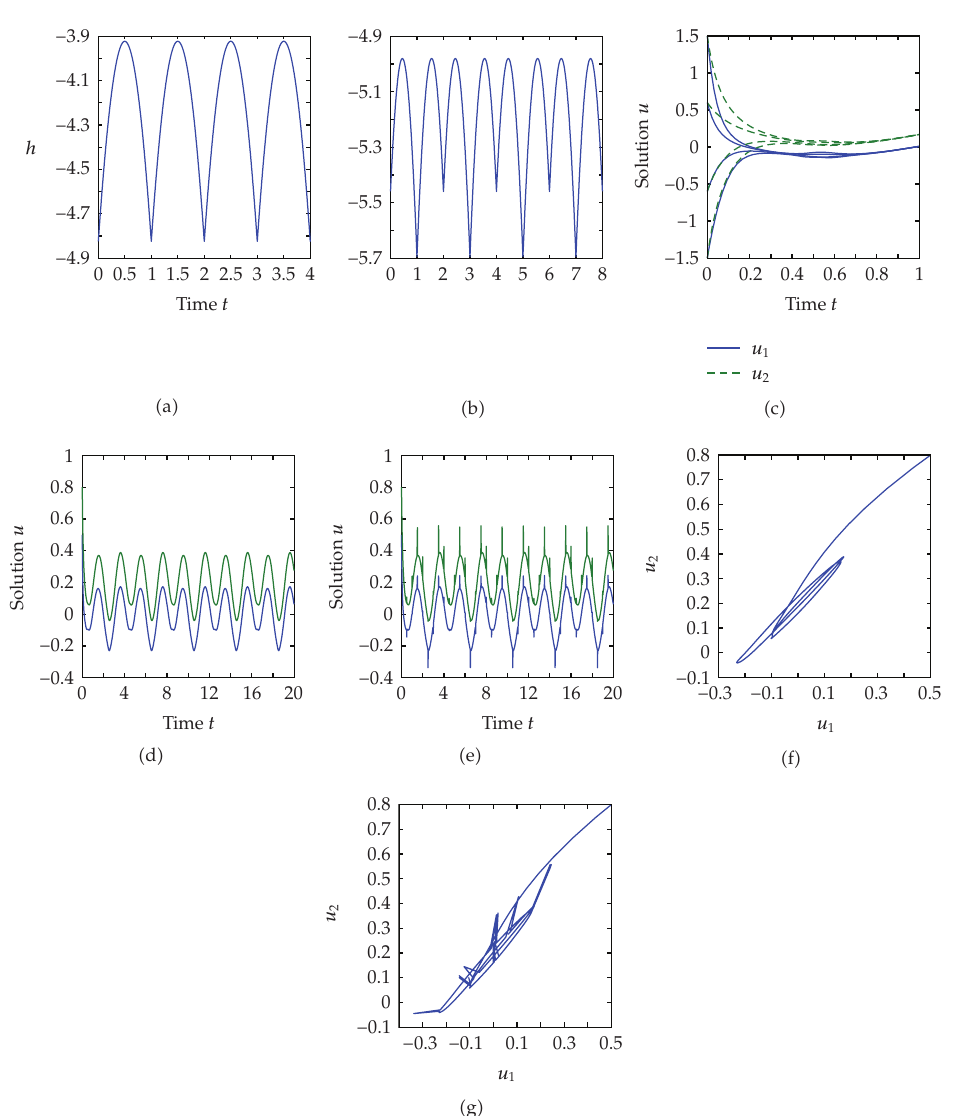
Figure 1: (cid:2) a (cid:3) The trajectory of h 1 (cid:2) λ (cid:3) . (cid:2) b (cid:3) The trajectory of h 2 (cid:2) λ (cid:3) . (cid:2) c (cid:3) Numeric simulation of (cid:2) u 1 ,u 2 (cid:3) . (cid:2) d (cid:3) Numeric simulation of (cid:2) u 1 ,u 2 (cid:3) without impulses. (cid:2) e (cid:3) Numeric simulation of (cid:2) u 1 ,u 2 (cid:3) with impulses. (cid:2) f (cid:3) Numeric simulation of (cid:2) u 1 ,u 2 (cid:3) without impulses. (cid:2) g (cid:3) Numeric simulation of (cid:2) u 1 ,u 2 (cid:3) with impulses.